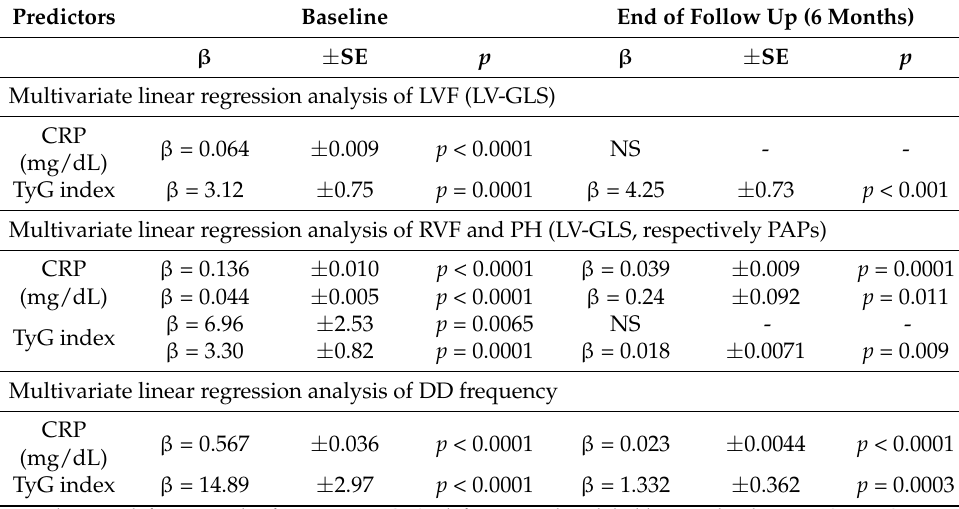
Table 5. Multivariate regression analysis used for the identification of objective predictors of LV-GLS, RV-GLS, DD, and PAPs initial values and six months’